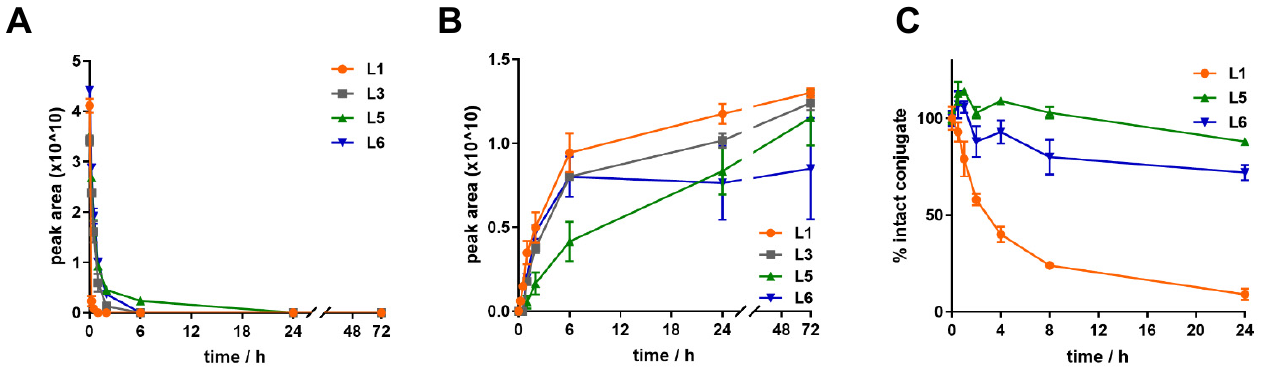
Figure 3. Stability profile of the conjugates in lysosomes and mouse plasma. ( A ) Degradation of L1 , L3 , L5 and L6 and ( B ) release of the active metabolite Dau=Aoa-Leu-OH in rat liver lysosomal homogenate (peak area, mean/10 10 ± SD, n = 3). ( C ) Stability of compounds L1 , L5 and L6 in mouse plasma over 24 h (%, mean ± SD, n = 3).